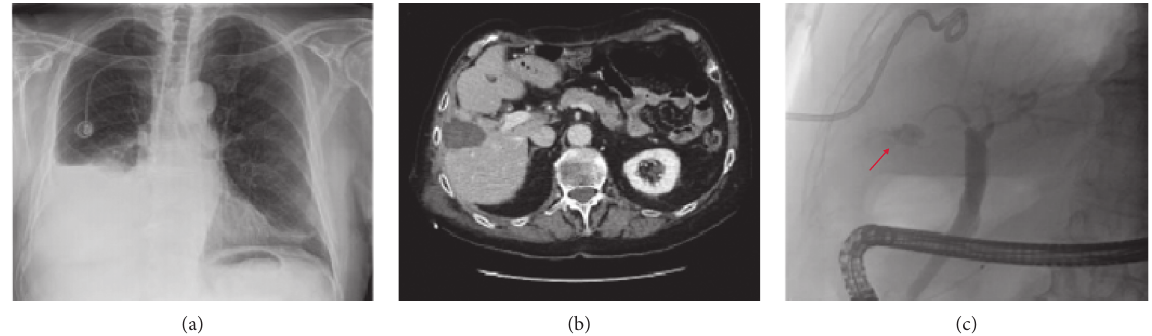
Figure 2: Chest plain radiograph 2 months after MWA showing a right pleural effusion (a); CT scan revealing a hypodense oval lesion of 48 × 33mm with hyperdense core consistent with postablation liver damage (b); and ERCP demonstrating contrast leakage from right-sided bile duct (arrow) and extravasation of contrast into the right pleural cavity (C).